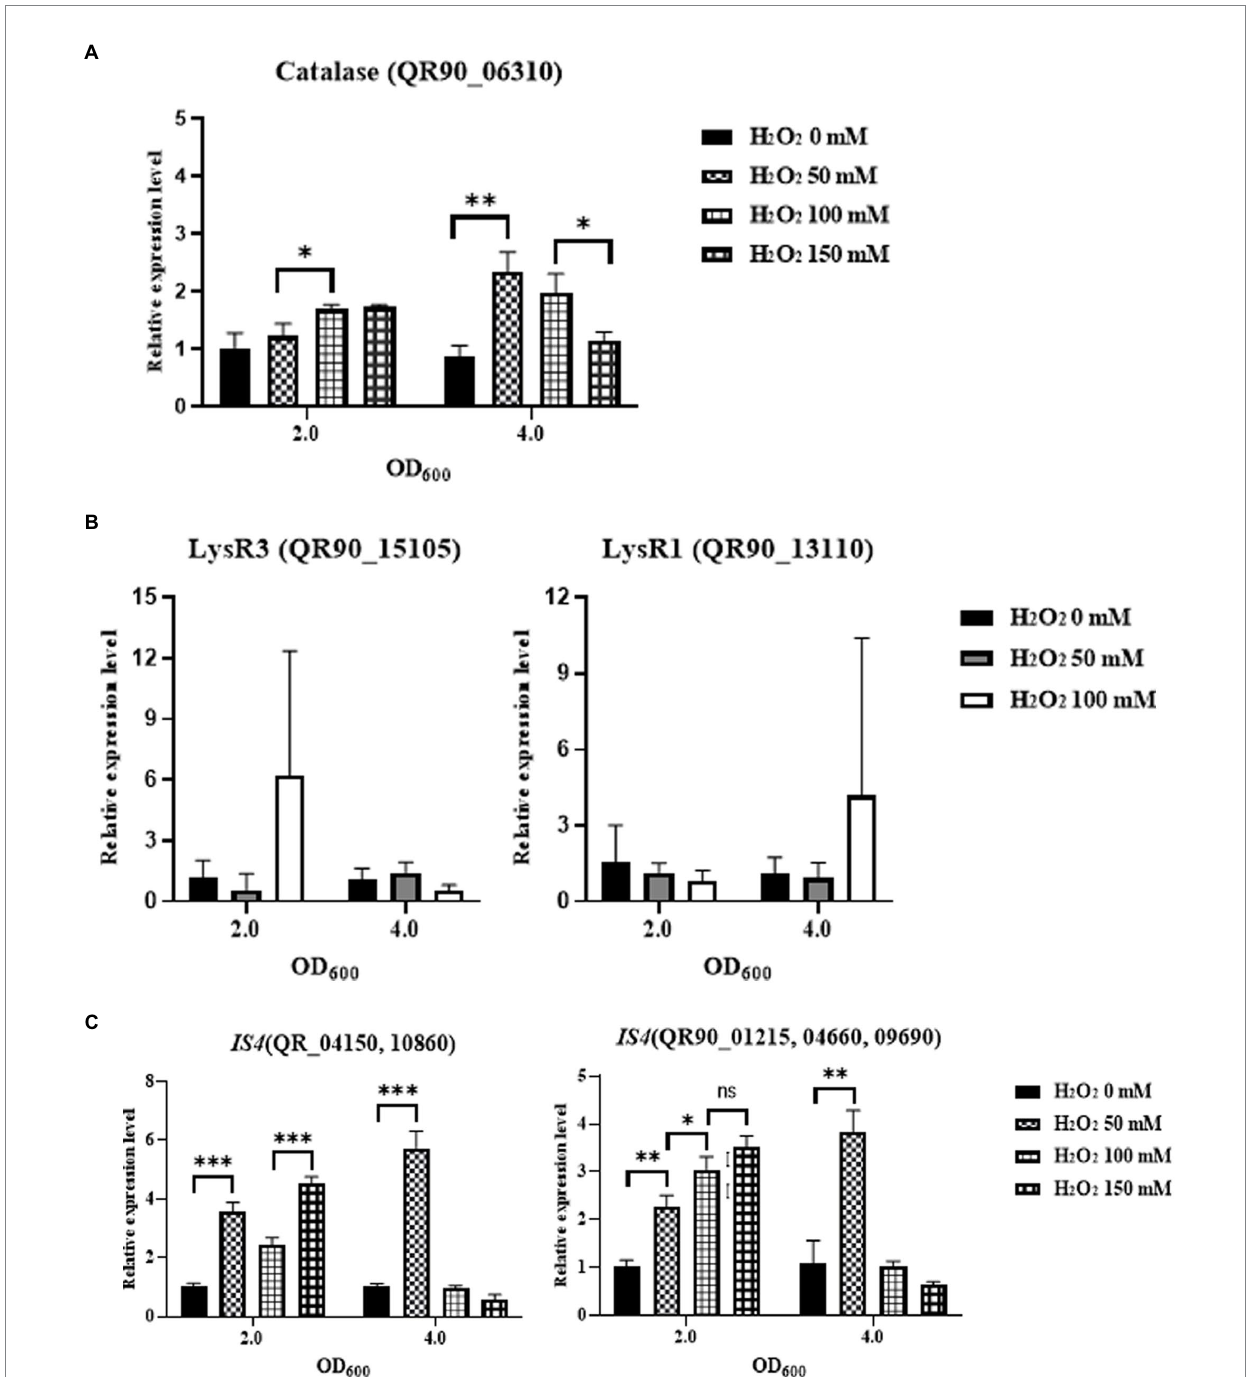
FIGURE 6 Comparison of the gene expression levels of catalase (A) , two LysR family regulators (B) and two transposases in IS Drpg2 and IS Drpg3 (C) by qRT-PCR under different final concentrations of H 2 O 2 (0–150 mM). Pair-wise comparisons between experimental groups were conducted via Student’s t -test with the Prism ™ ver. 8.0 software (* p < 0.05; ** p < 0.01; *** p <